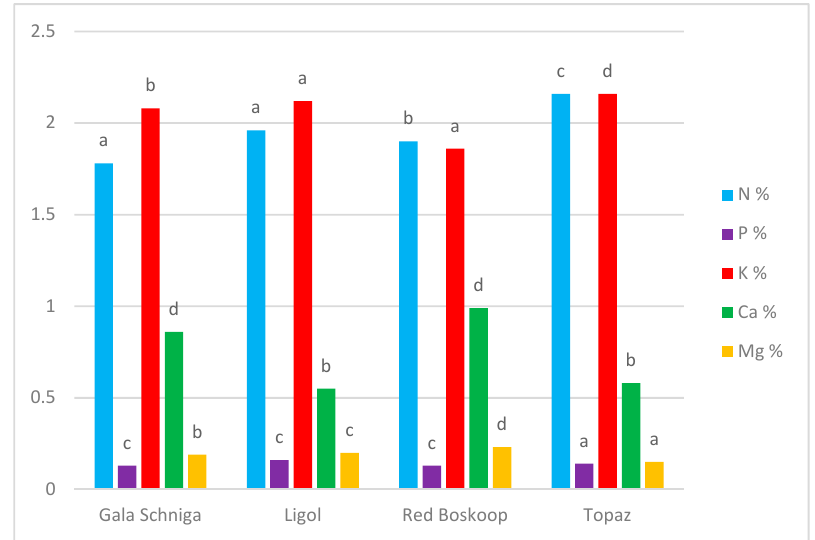
Figure 2. A comparison of the contents of macronutrients in the leaves of maiden apple trees depending on the variety used. Data followed by the same letters do not differ significantly at p = 0.05 for each macronutrient according to Tukey’s test.